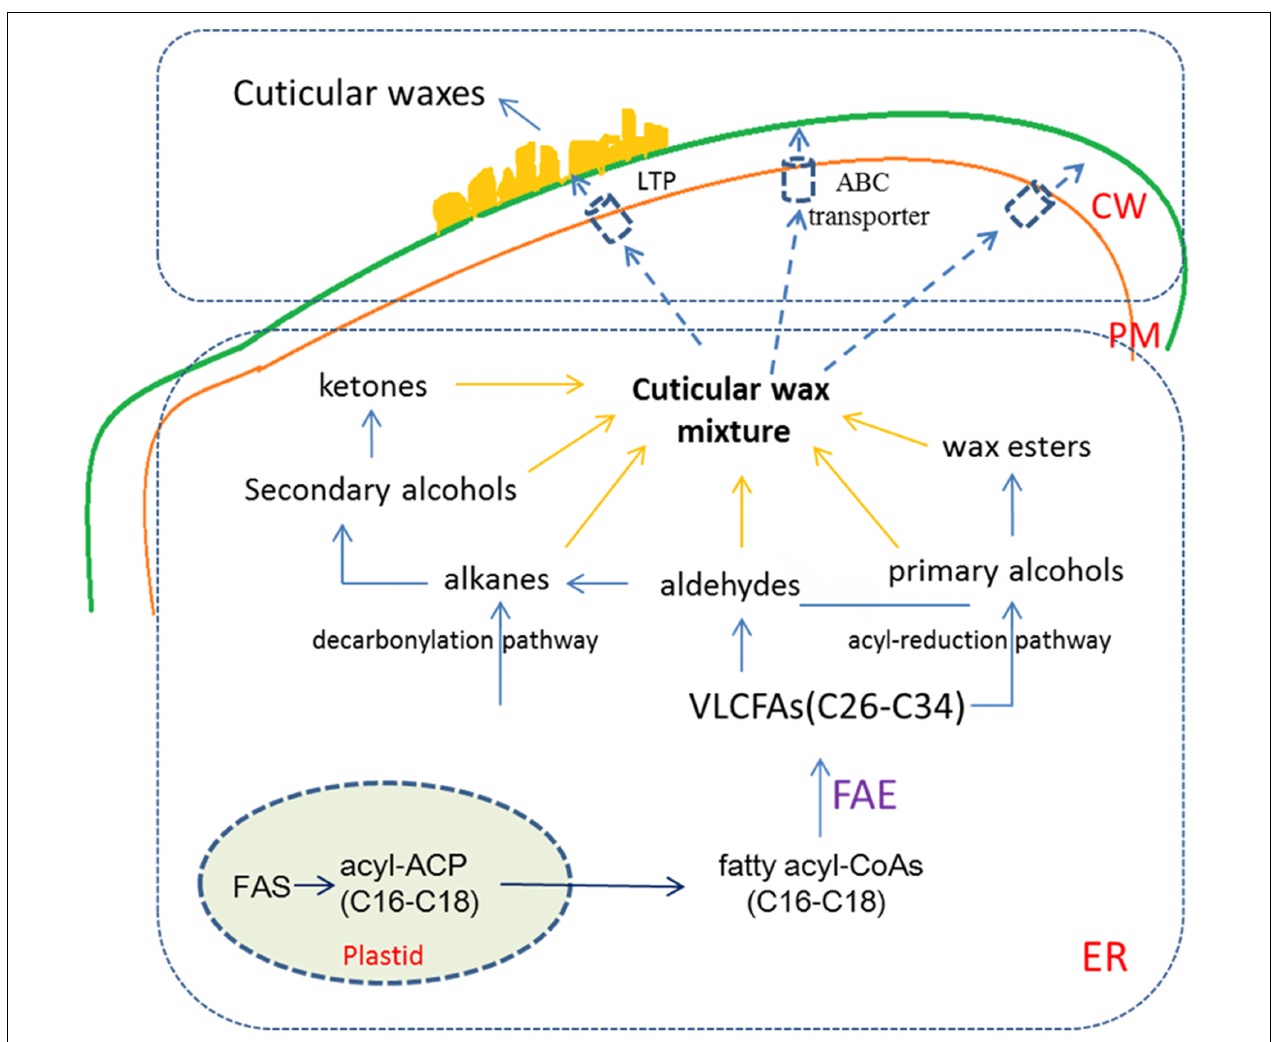
FIGURE 1 | The biosynthesis and transport of plant cuticular wax. In epidermal cells, C 16 and C 18 fatty acids are synthesized in the plastid, then C 16 and C 18 fatty acyl-CoAs are elongated to VLCFAs (C 26 to C 34 ) in the ER. VLCFAs are modified according to two distinct biosynthetic pathways to generate the aliphatic compounds of waxes. In the interaction of ABC transporter and LTP, wax mixture are mobilized from the ER to the PM, and then exported from the PM to the extracellular matrix. CW, cell wall; ER, endoplasmic reticulum; PM, plasma membrane; FAE, fatty acid elongase; ABC transporter, ATP binding cassette transporter; LTP, lipid transfer